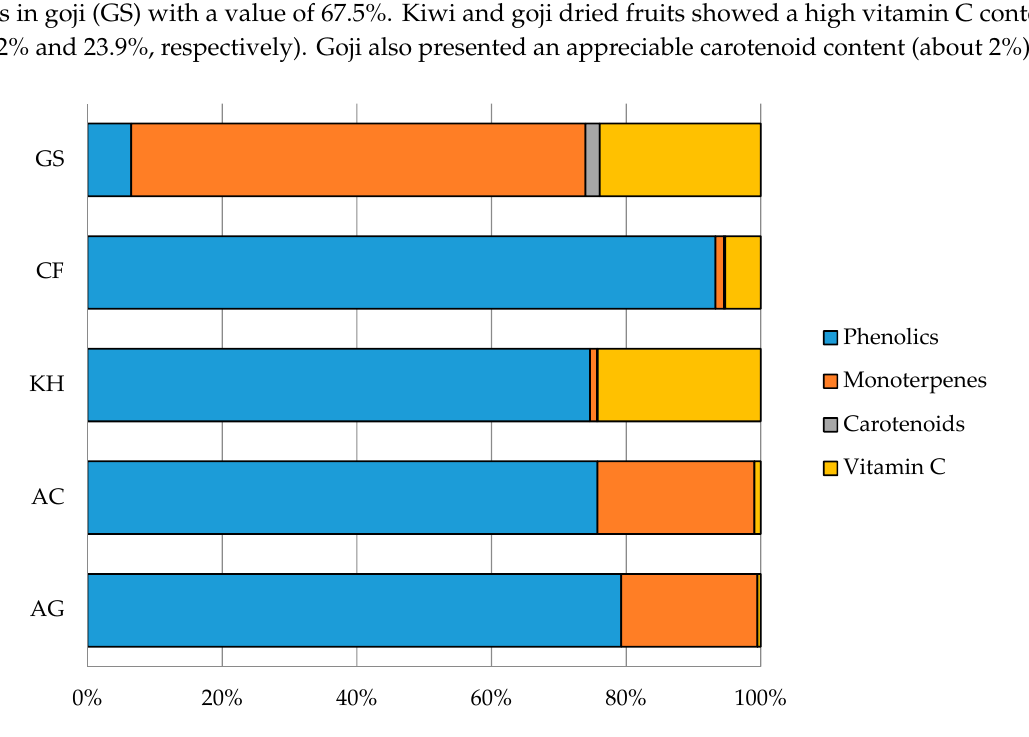
Figure 1. Phytocomplex of analysed dried fruit products. Mean values are given ( n = 3). AG = Malus domestica Borkh., ‘Golden Delicious’; AC = Malus domestica Borkh., ‘Camela’; KH = Actinidia deliciosa (A.Chev.) C.F.Liang and A.R.Ferguson, ‘Hayword’; CF = Diospyros kaki L.F., ‘Fuyu’; GS = Lycium barbarum L.,